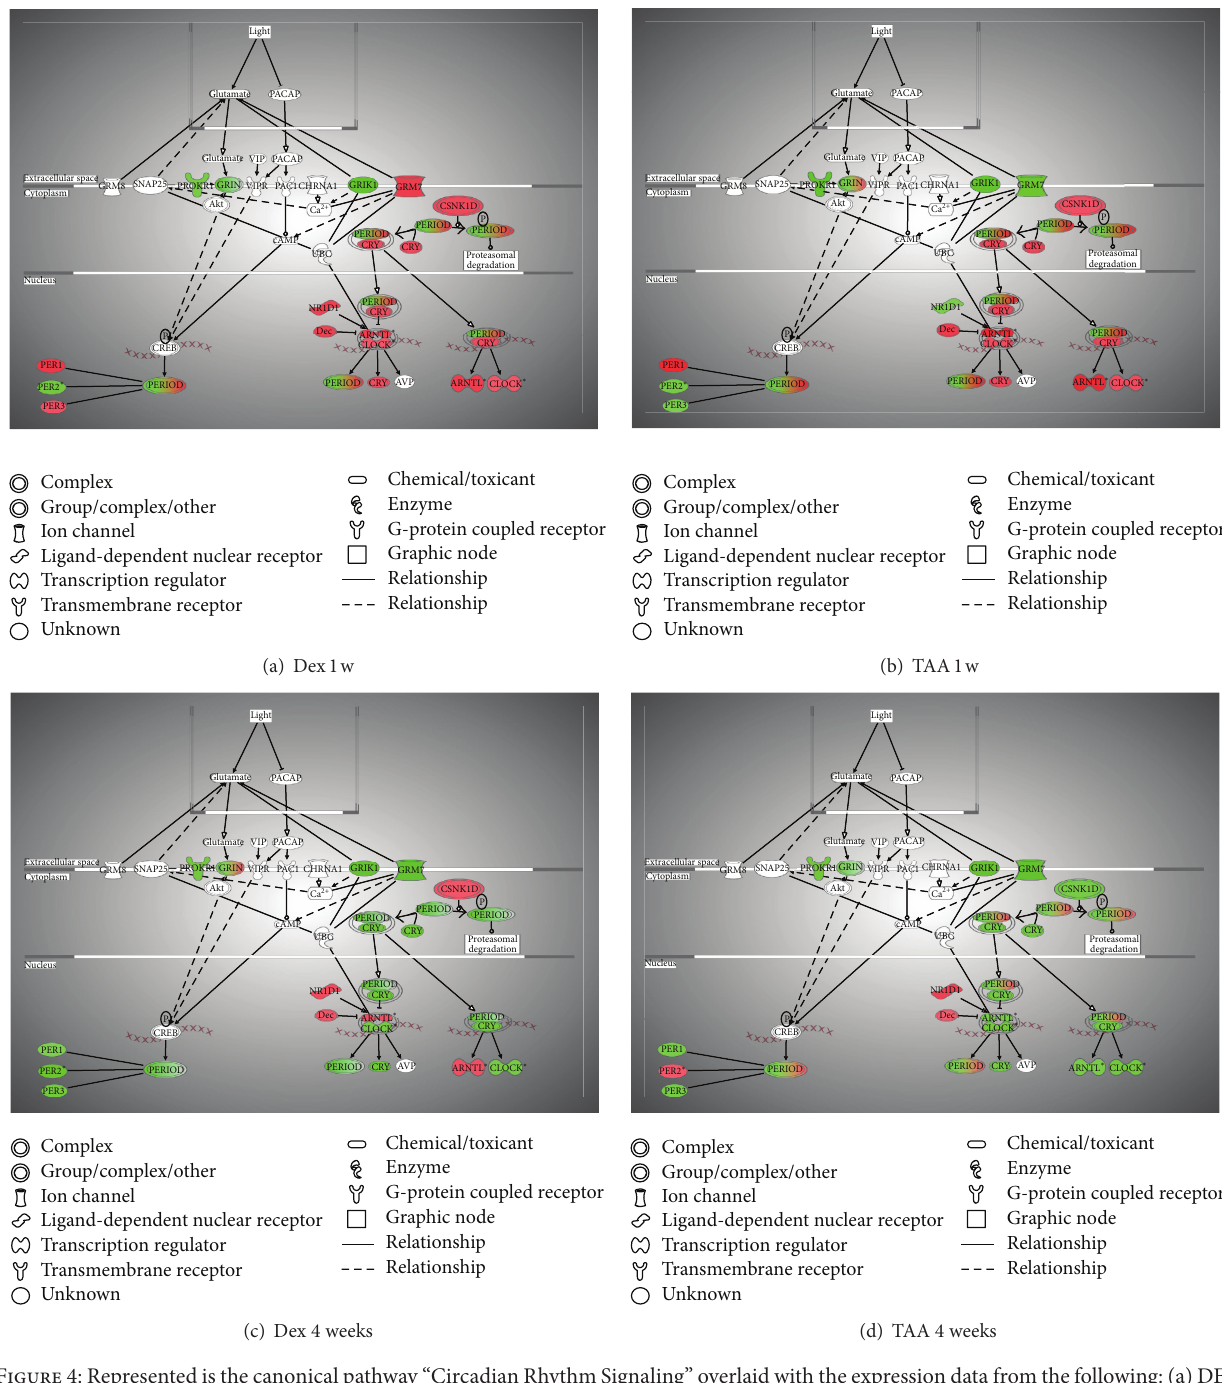
Figure 4: Represented is the canonical pathway “Circadian Rhythm Signaling” overlaid with the expression data from the following: (a) DEX versus Con at 1 week, (b) TAA versus Con at 1 week, (c) DEX versus Con at 1 month, and (d) TAA versus Con at 1 month postinjection. Data is represented as fold change of sample to control, 𝑝 < 0.05 from ANOVA analysis. Red color means upregulation, while green means downregulation of the gene